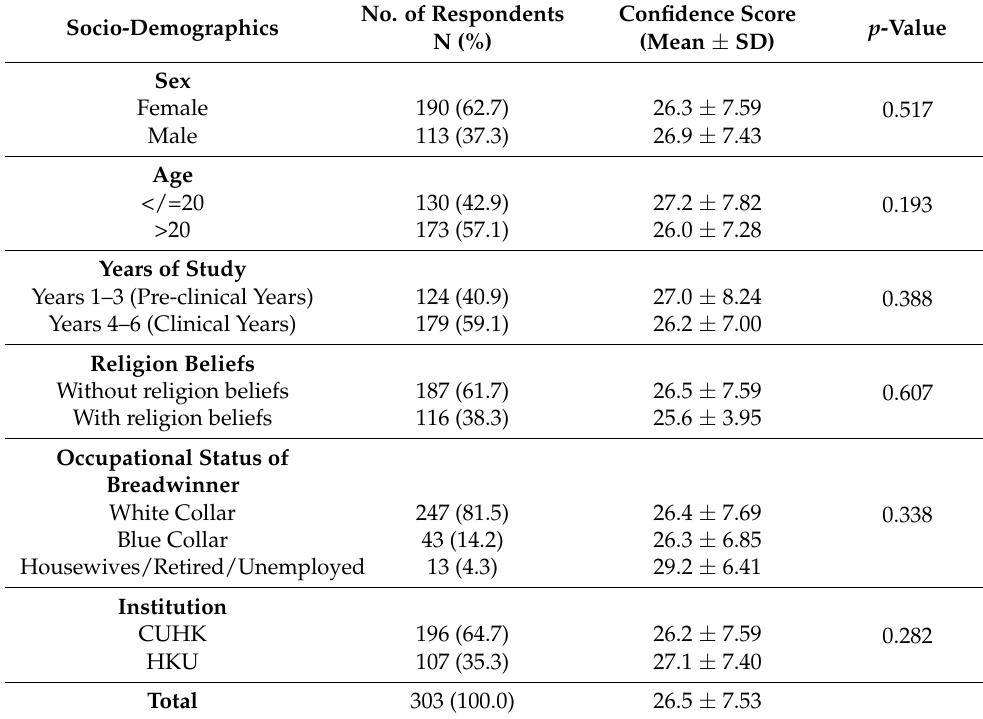
Table 1. Association between demographics and confidence towards providing palliative care among medical